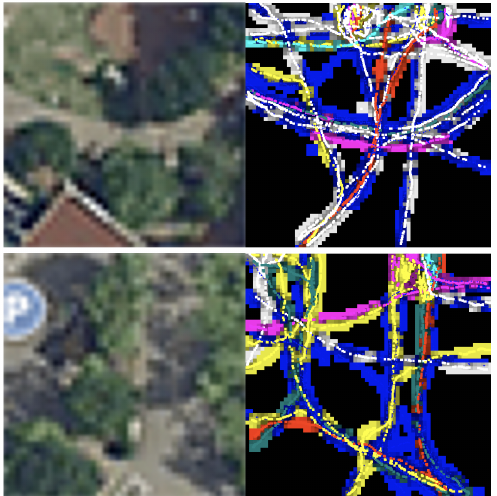
Figure 8. Classification results inside buildings (Communication, white; Entertainment,